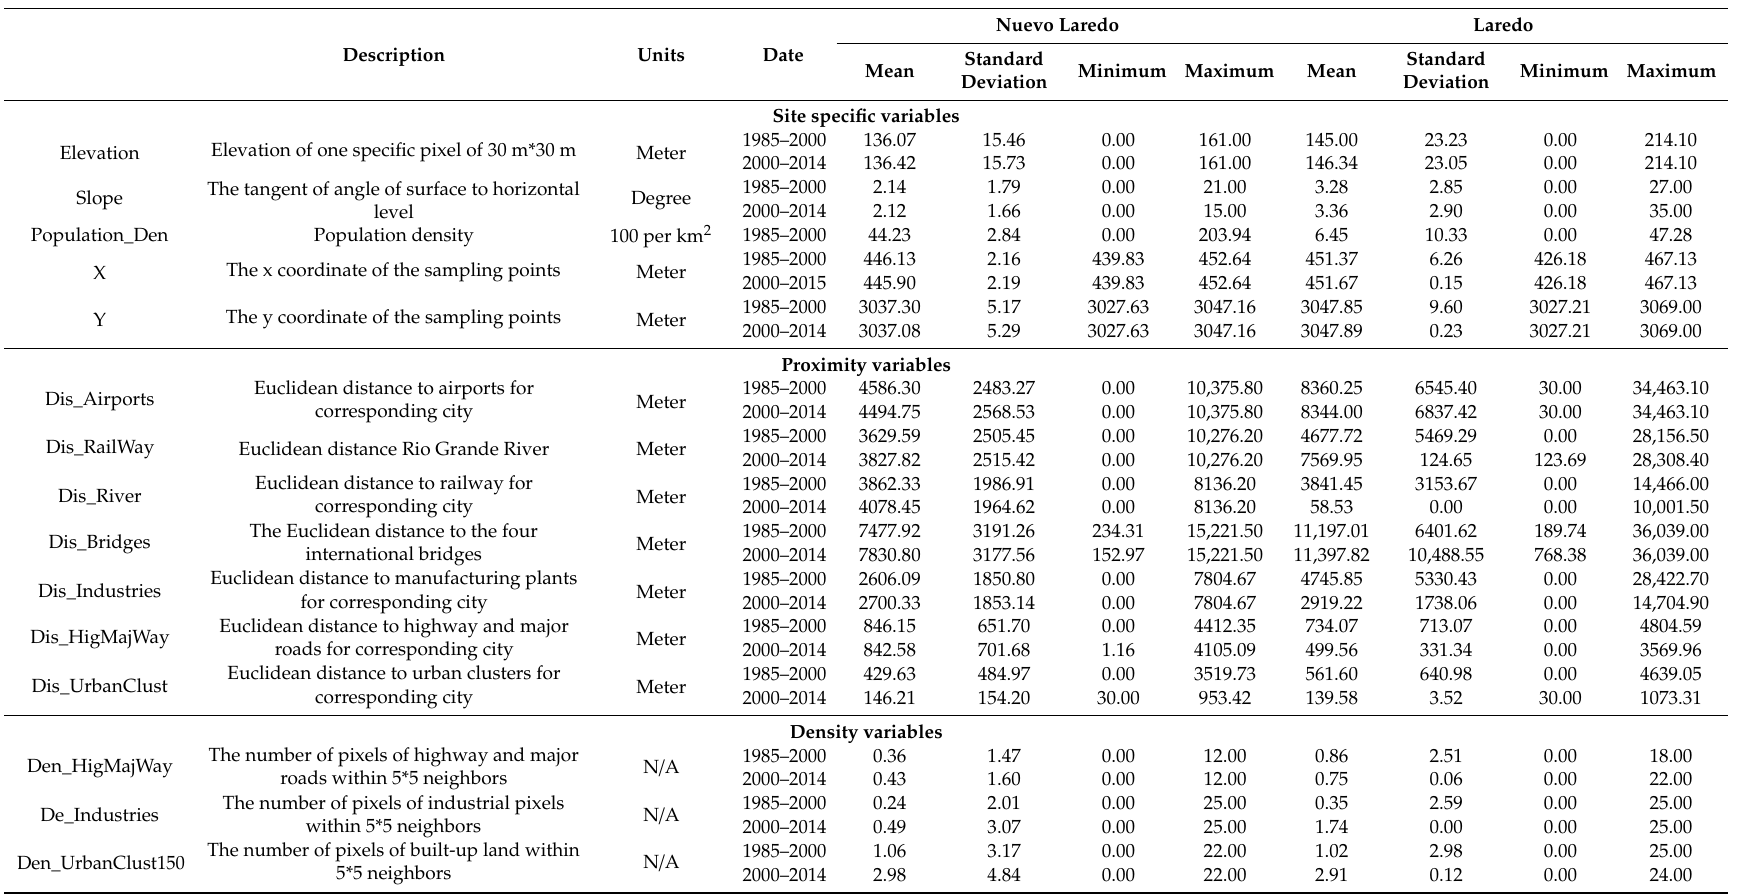
Table 1. Descriptive statistics of original collected dataset in this